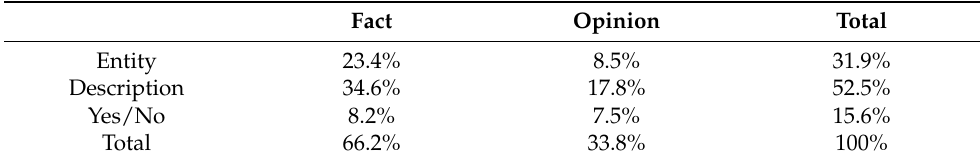
Table 5. Percentage of six types of questions in our NJTG datasets.